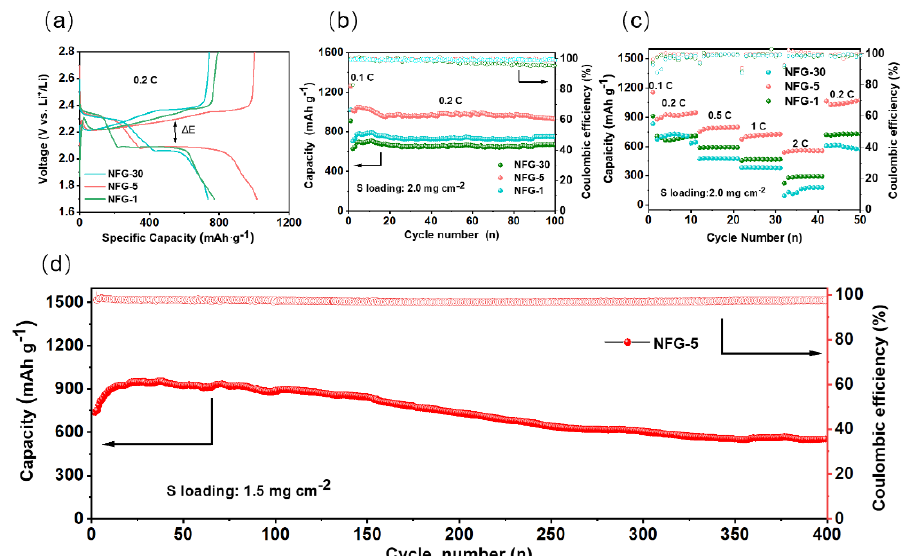
Figure 4. Electrochemical performance of NiFeLDH/rGO cathodes. ( a ) Discharge–charge profiles, ( b ) cycling performance at 0.2 C, and ( c ) rate capabilities of S@NFG-1, S@NFG-5, and S@NFG-30, respectively. ( d ) Cycling performance of S@NFG-5 electrode with S areal mass loading of 1.5 mg cm −2 .